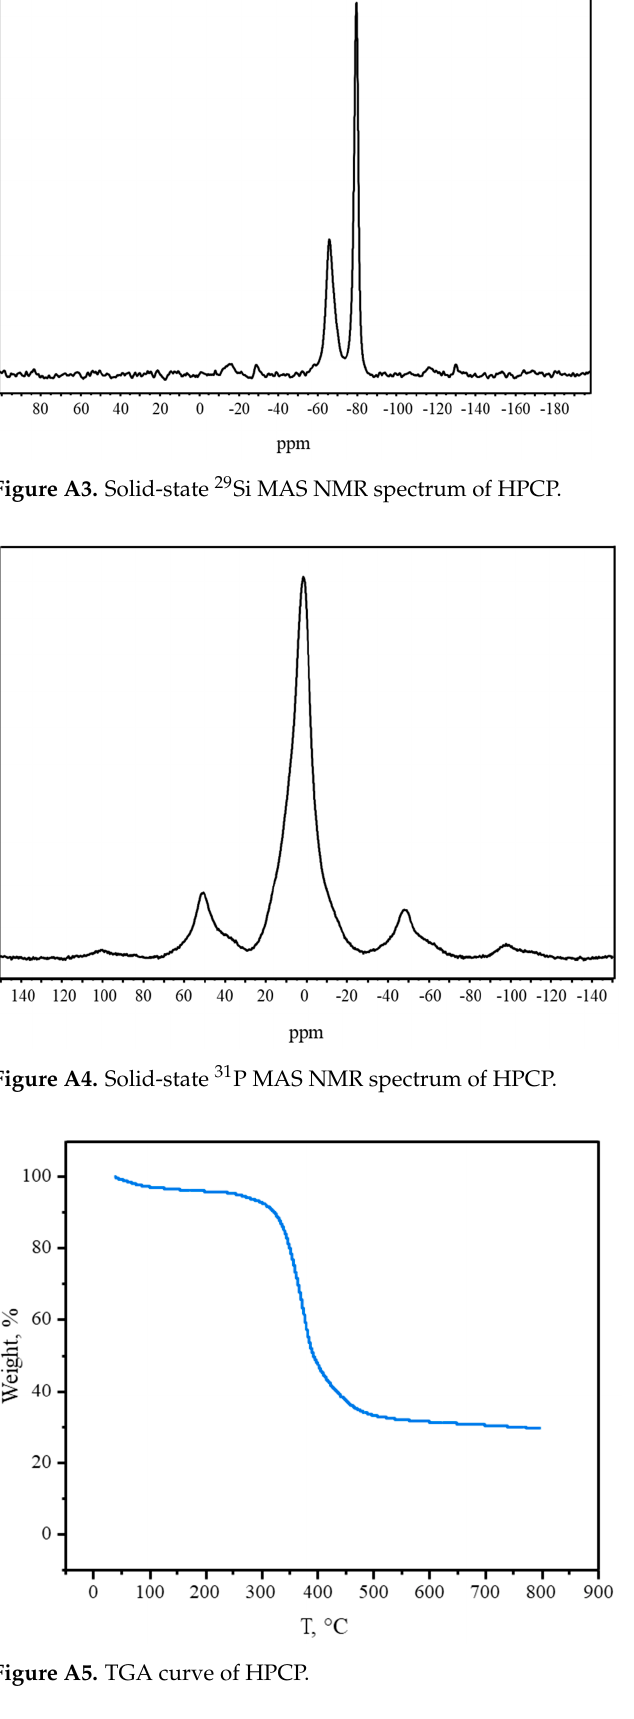
Figure A2. Solid-state 13 C CP/MAS-NMR spectrum of HPCP.